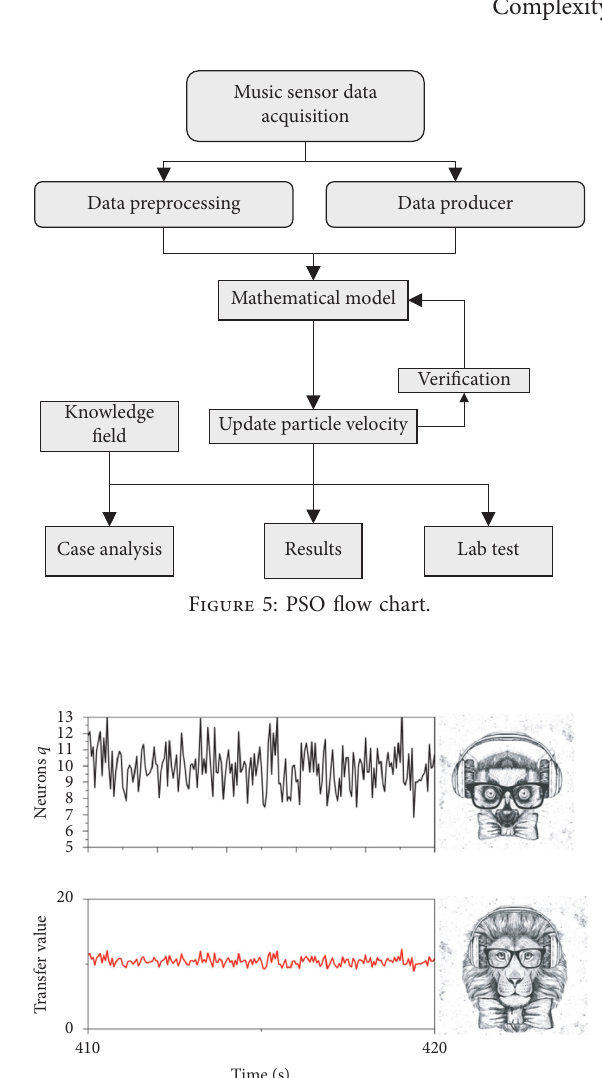
Figure 6: Experimental measurement of the number of neurons q in the hidden